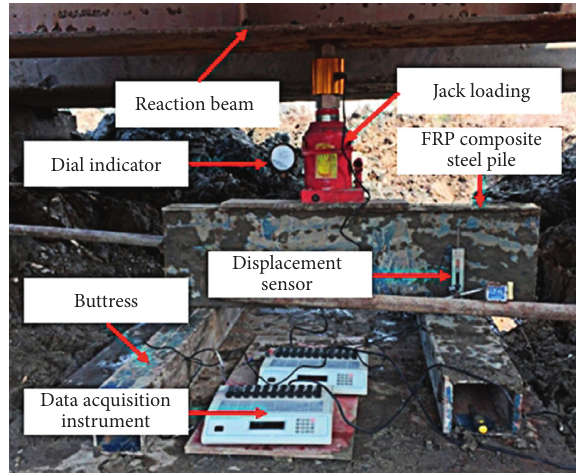
Figure 4: Vertical bearing capacity of FRP composite sheet piles for field loading testing.